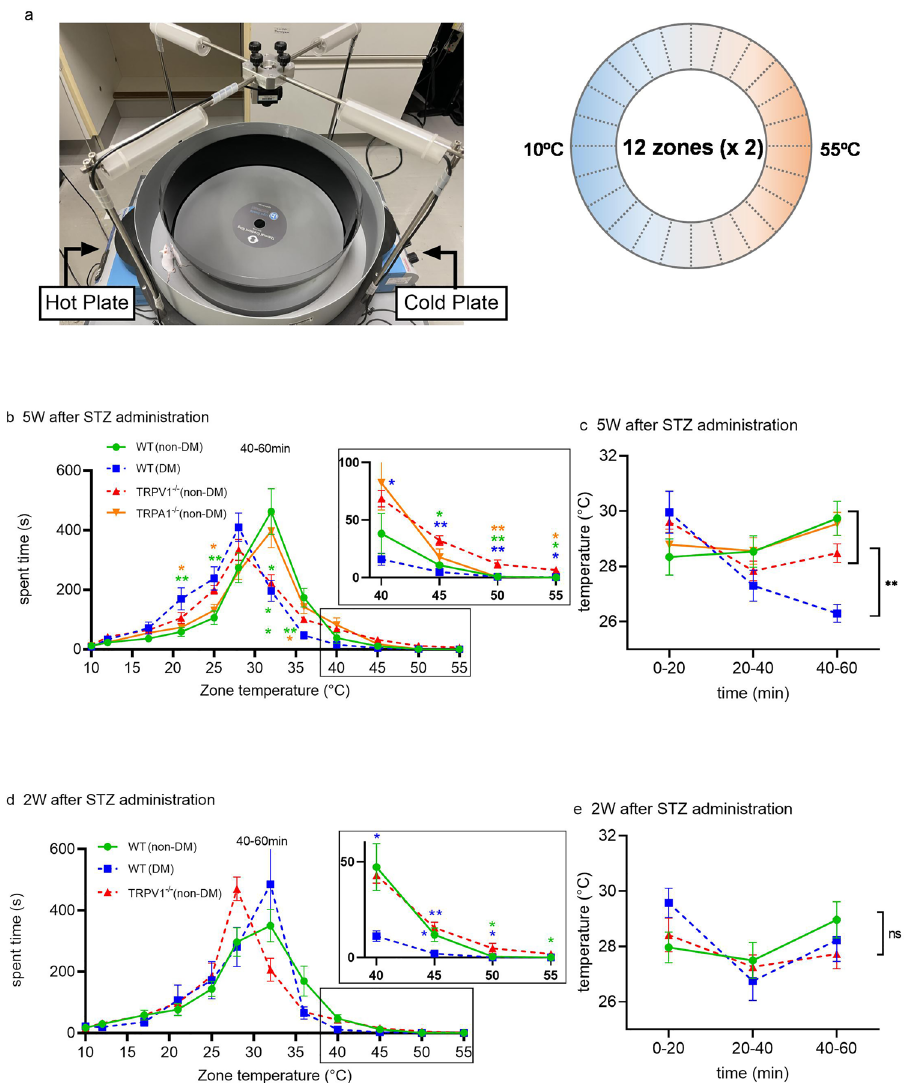
Figure 5. Thermal behavior assay with the Thermal Gradient Ring. ( a ) Image showing the Thermal Gradient Ring with a mouse (left) and an image of the floor of the Thermal Gradient Ring with 24 zones from 10 to 55 °C (right). ( b ) Comparison of “spent time” of 4 groups (WT (DM) mice 5 weeks after STZ administration (n = 10), and WT (non-DM) (n = 10), TRPV1 −/− (non-DM) (n = 10), TRPA1 −/− (non-DM) (n = 9) mice at the same age) during 40–60 min in the 60 min trial. Expanded data at 40–55 °C zones are also shown ( b , right). ( c ) Mean values of preferred temperatures calculated from “spent time” and zone temperatures of ( b ), in the first, mid, and last 20 min. ( d ) Comparison of “spent time” of 3 groups (WT (DM) mice 2 weeks after STZ administration (n = 8), and WT (non-DM) (n = 10), TRPV1 −/− (non-DM) (n = 5) mice at the same age) during 40–60 min in the 60 min trial. Expanded data at 40–55 °C zones are also shown ( b , right). ( e ) Mean values of preferred temperatures calculated from “spent time” and zone temperatures of ( d ), in the first, mid and last 20 min. The data are presented as the means ± SEM. A one-way ANOVA followed by a Bonferroni post hoc test was used for comparisons. * p < 0.05 and ** p < 0.01. ns = not